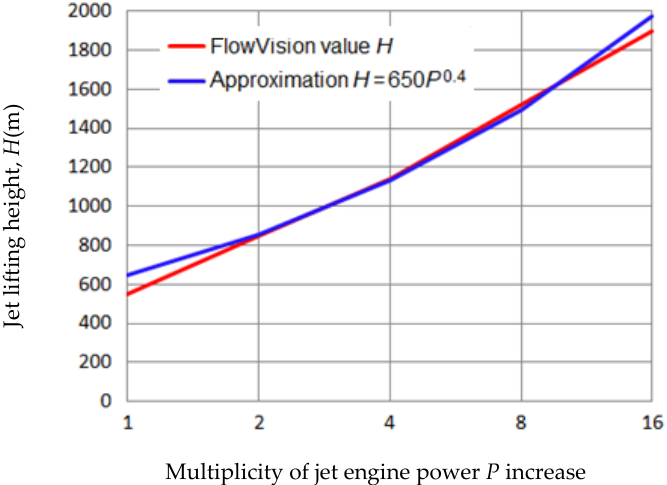
Figure 17. Dependence of jet lifting height H from turbojet engine power P.